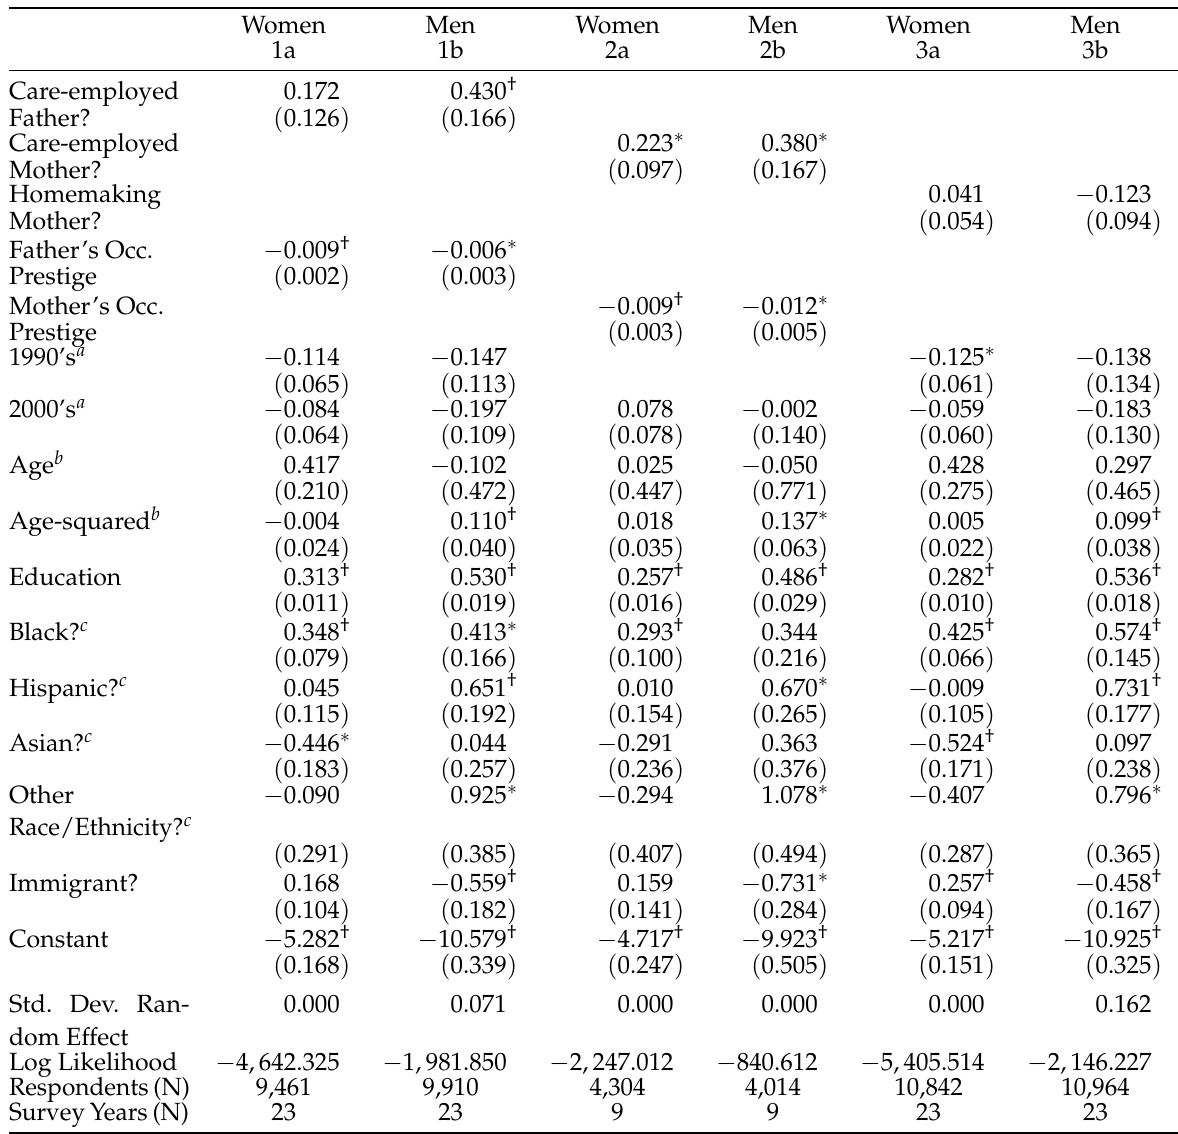
Table 2: Logistic Regression Models Predicting Incumbency in Care Occupations Women